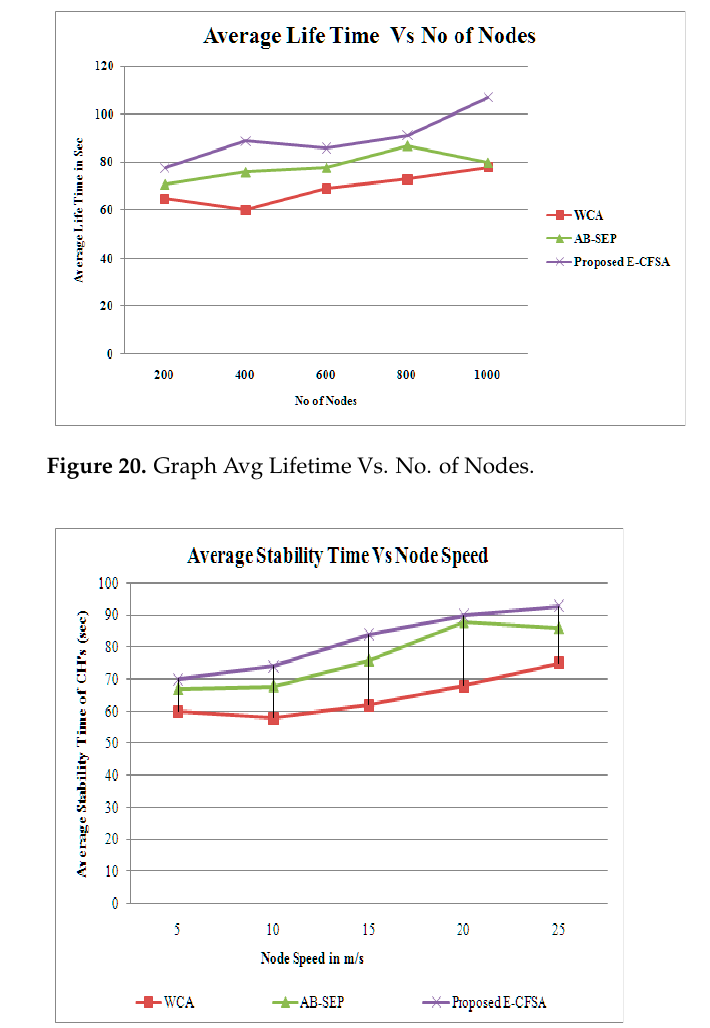
Figure 19. Graph Throughput Vs. No. of Nodes.